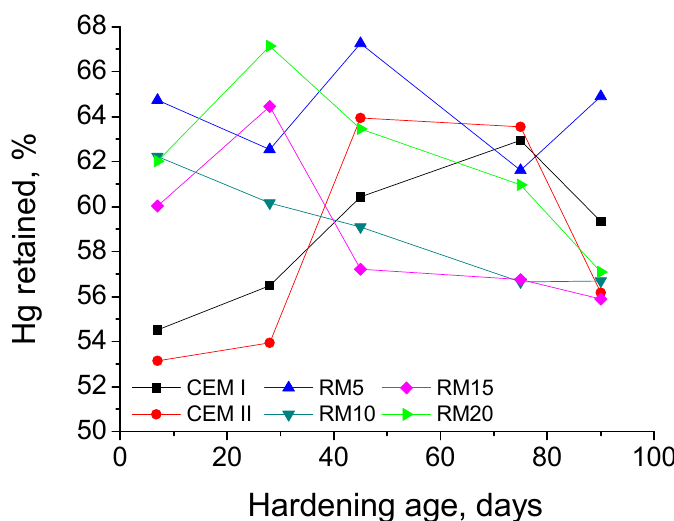
Figure 6. Evolution of Hg retained once porosimetry testing was completed for the studied mortars.